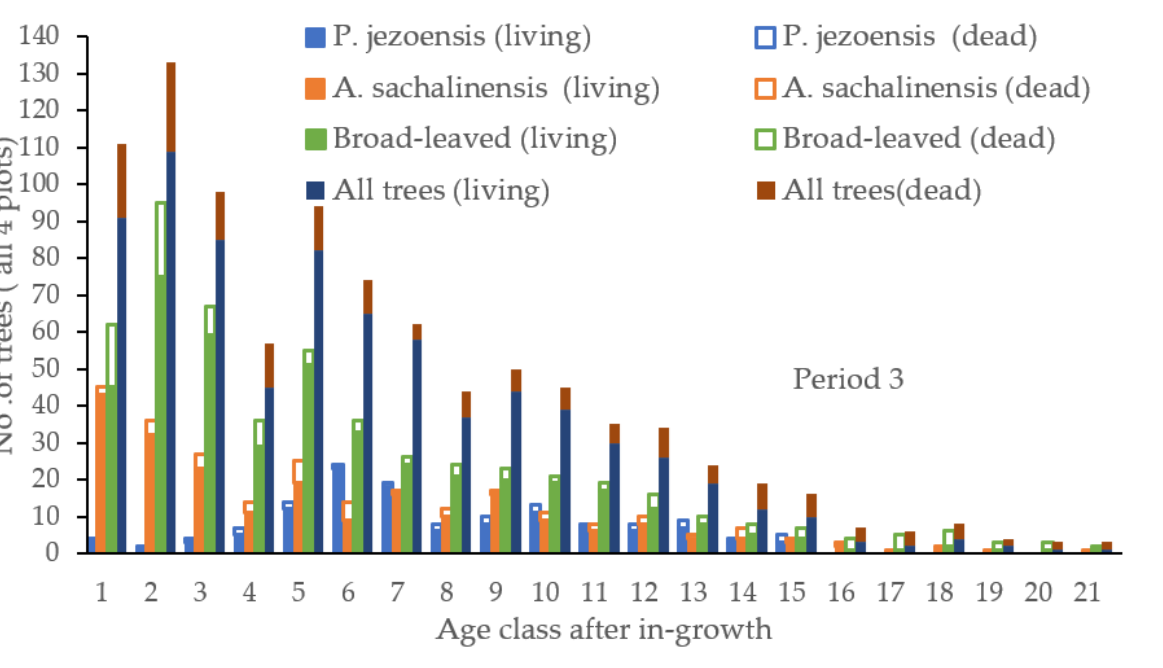
8 of 20 Table 2. Log ‐ rank test and Wilcoxon results of each tree group to compare the three observational periods. Period Tree Species A. sachalinensis P. jezoensis